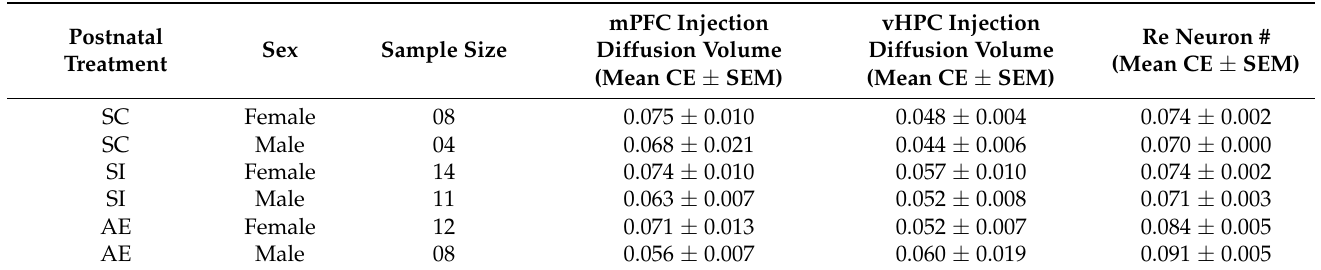
Table 2. Sample sizes and mean Gundersen (m = 1) coefficients of error (CEs) [54]. Stereological estimates included diffusion of AAVrg-CAG injections in mPFC and vHPC, and Re neuron number in the hemisphere ipsilateral to AAV injections. Estimates are commonly accepted as robust and reliable if CE values are below 0.100